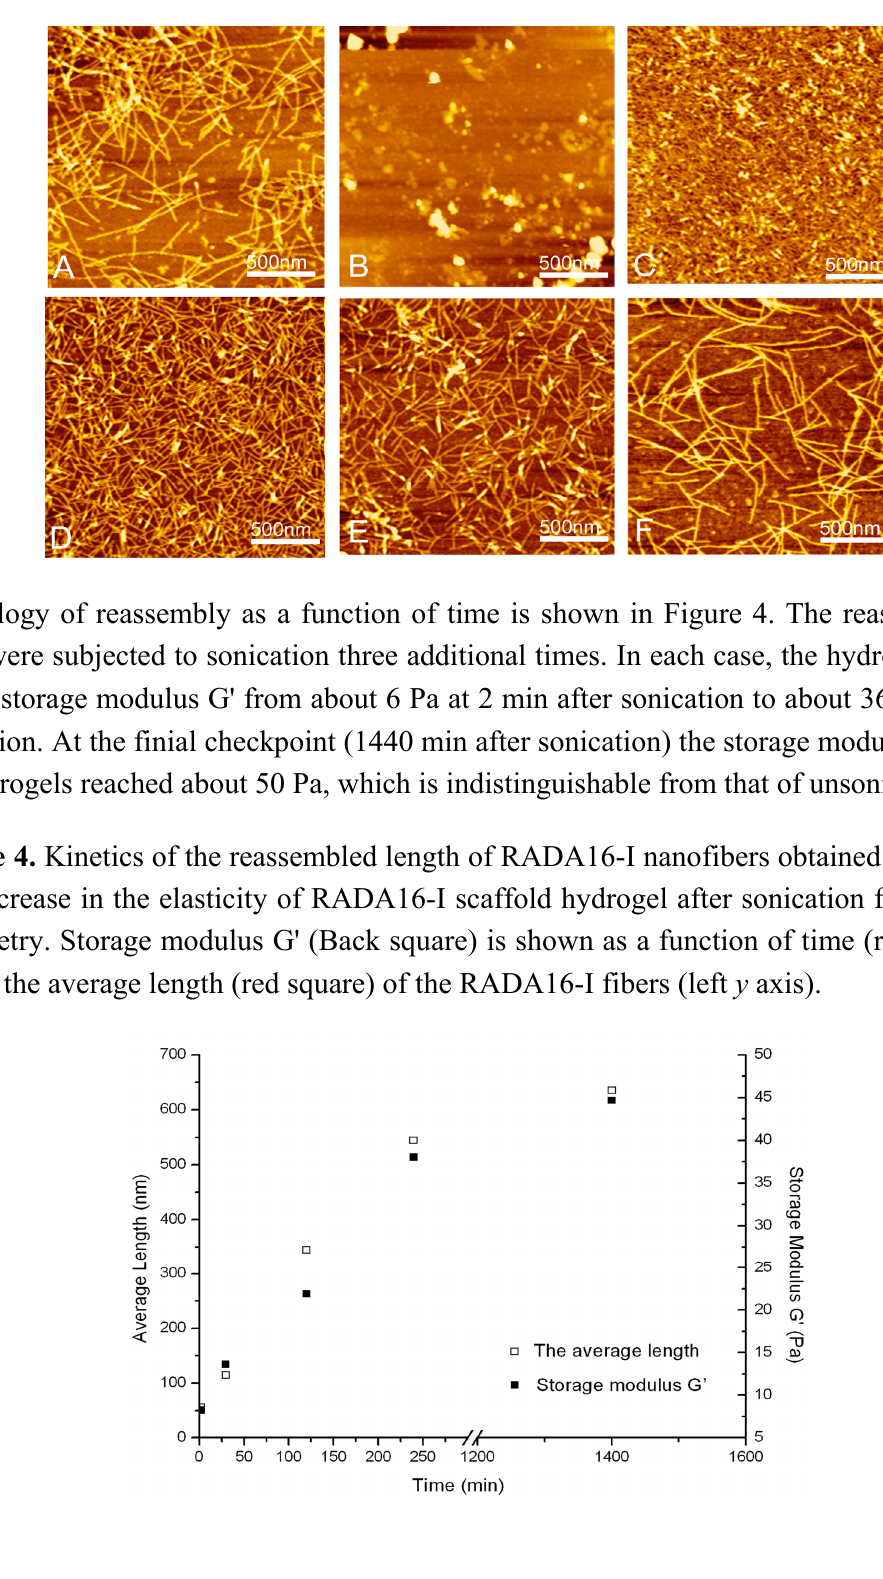
Figure 3. AFM images of RADA16-I nanofibers at various points in time: ( A ) before sonication; ( B ) 2 min after sonication; ( C ) 30 min; ( D ) 2 h; ( E ) 4 h; and ( F ) 24 h. Note the elongation and reassembly of the peptide nanofibers over time.